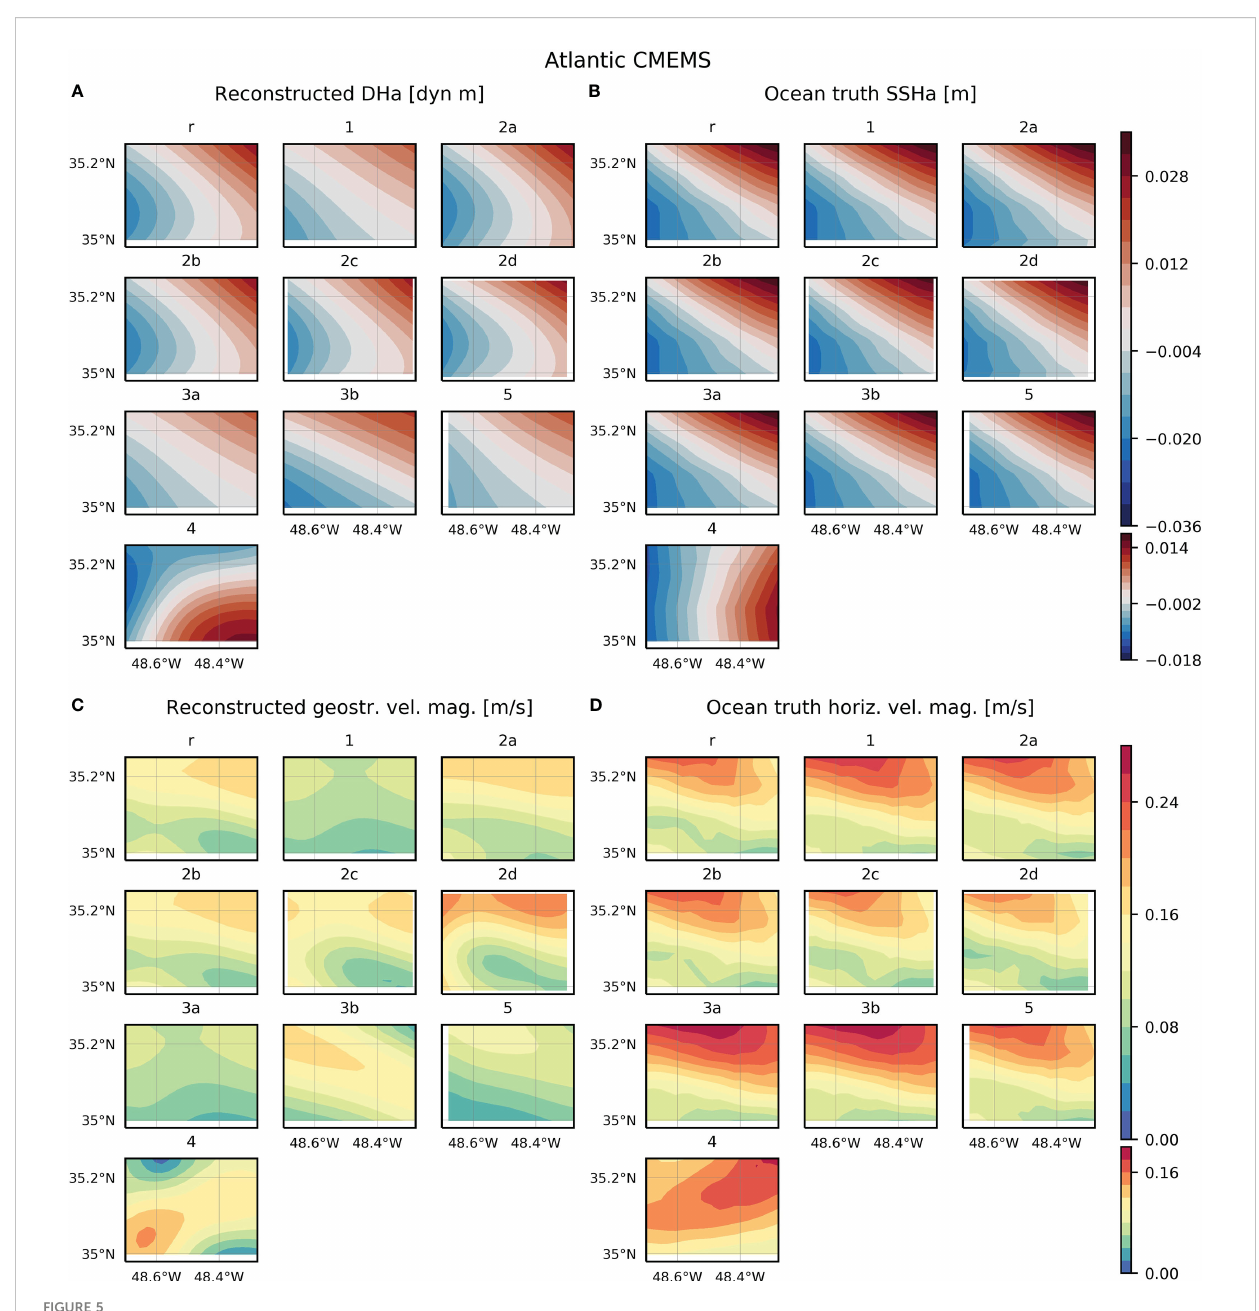
FIGURE 5 (A) Dynamic height anomaly (DHa) at the upper layer reconstructed from each con fi guration simulated from the CMEMS global reanalysis in the Atlantic study region. (B) Sea surface height anomaly (SSHa) from the CMEMS global reanalysis on the same date as each reconstruction. To compute anomalies, the spatial average is subtracted to the corresponding fi eld. (C) Geostrophic velocity magnitude at the upper layer reconstructed from each con fi guration simulated from the CMEMS global reanalysis in the Atlantic study region. (D) Horizontal velocity magnitude from the CMEMS global reanalysis on the same date as each reconstruction. Note that to calculate statistics model fi elds are interpolated onto the reconstruction grid and statistics are computed only considering data within the domain of con fi guration